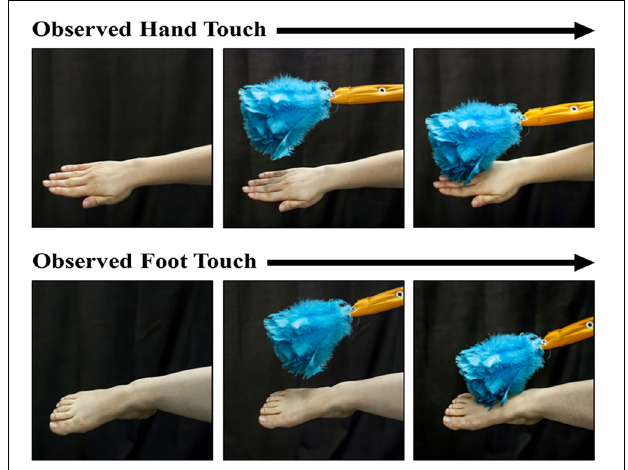
FIGURE 1 | Photographs of the hand-touch and the foot-touch events observed by the infants during a trial. The presentations were accomplished by a live person and thus involved dynamic stimuli. A feather duster came into view and touched the experimenter’s hand or foot for the duration of two tactile stimulations to the infant’s right hand or foot (see text for stimulus-parameter